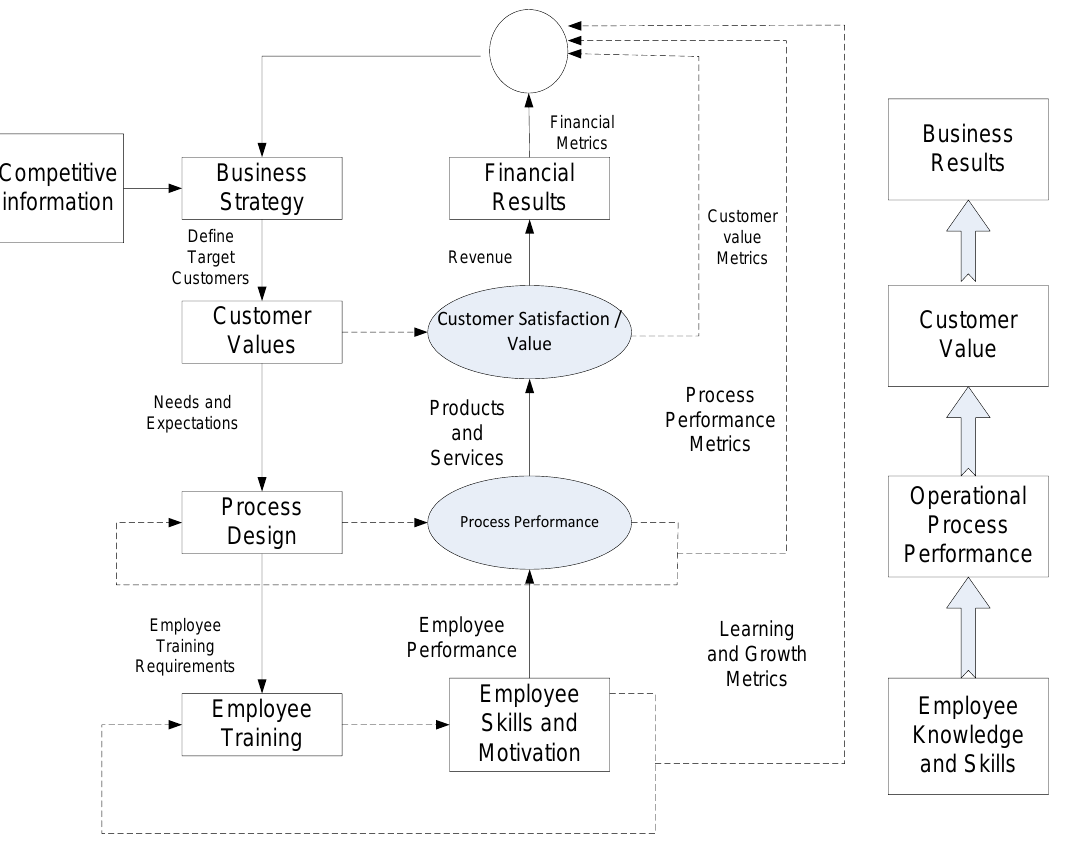
Fig. 4. Business metrics and strategy alignment (Cobb,